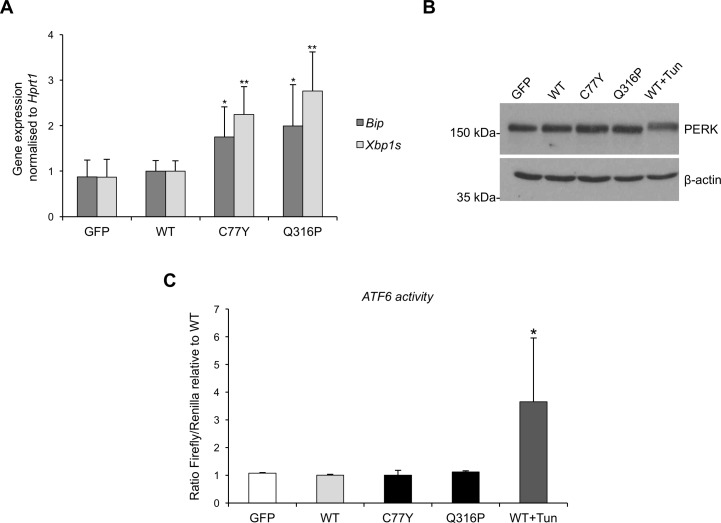
Analysis of UPR induction in mTAL cells expressing different uromodulin mutants.(A) Bip and spliced Xbp1 expression assessed by real time RT-qPCR. Expression is normalised to Hprt1. *P<0.05, **P<0.01 (Student t test vs GFP and WT) (n = 6 independent experiments). (B) Western blot analysis of PERK in mTAL cells expressing mutant uromodulin isoforms. None of the mutant isoforms is inducing PERK phosphorylation, seen as a shift in protein migration, as observed upon tunicamycin treatment (2 μg/mL for 14 h). (C) ATF6 activity as assessed by use of an ATF6 reporter construct. No ATF6 activation is observed in mutant uromodulin expressing cells. WT cells treated with tunicamycin are shown as a positive control *P<0.05 (Student t test vs WT) (n = 6 independent experiments).